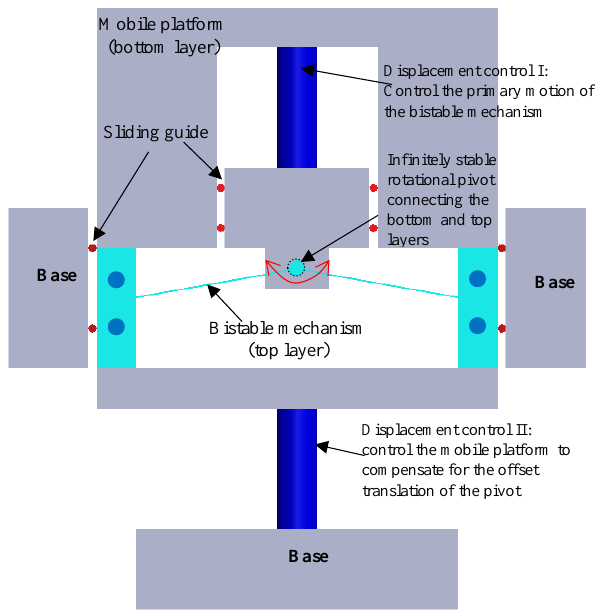
Figure 7. Schematic deisgn for the infinitely-stable rotational mechanism.